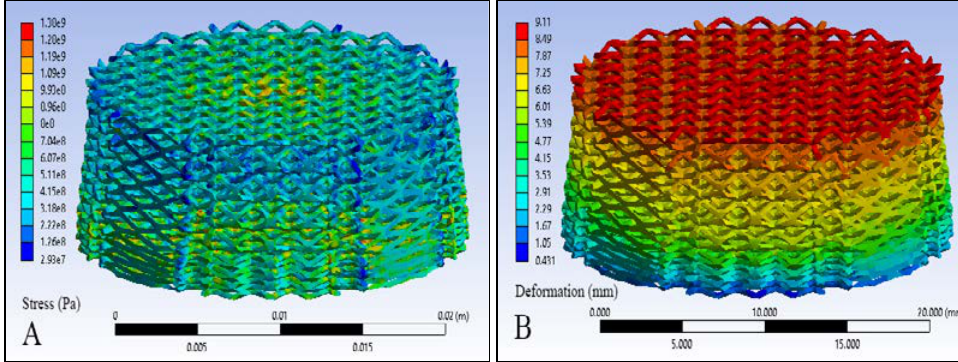
Figure 5 . Lattice scaffold simulation: ( A ) Stress and ( B ) displacement (final height after compression 15 − 9.11 = 5.89 mm; red dots are separated particles in contact with compressive punches).